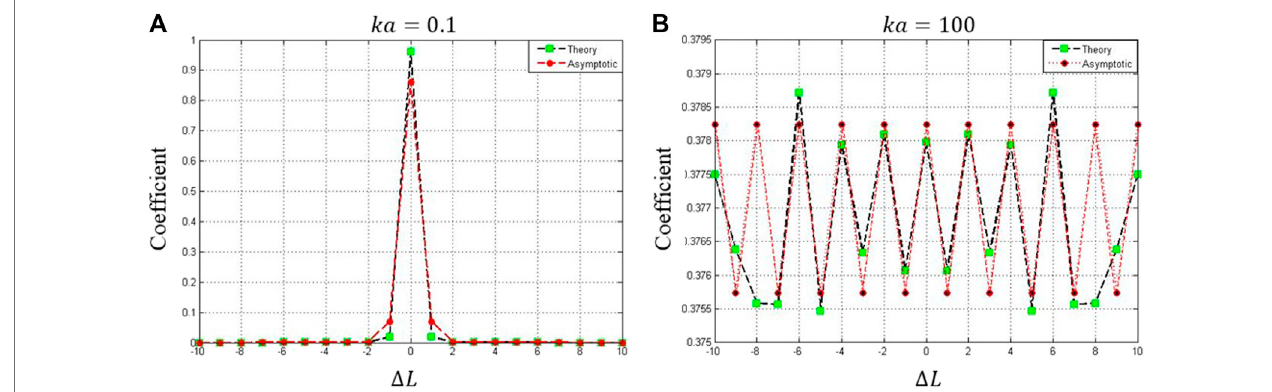
FIGURE 1 | The spiral spectrum of OAM mode for phase tilt. ka (cid:2) 0 . 1 for (A) and ka (cid:2) 100 for for (B) .